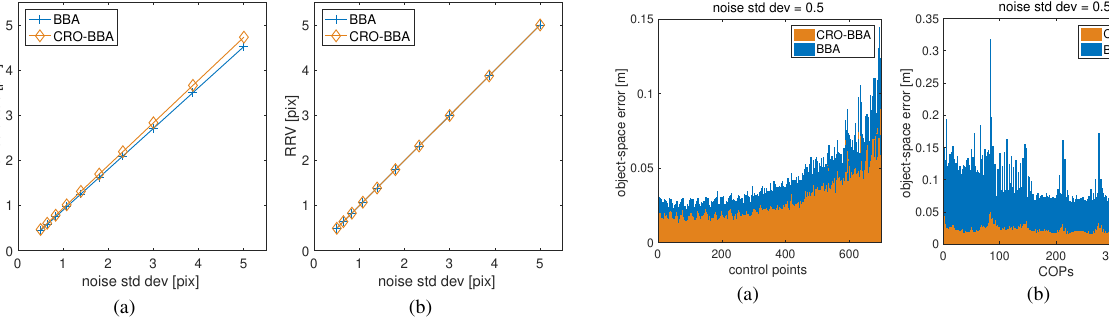
Figure 6. Object-space errors for control points (a) and COPs (b) for 0.5 pixels noise standard deviation. In (a) points are sorted by decreasing ray-multiplicity. This figure is best viewed in colour.